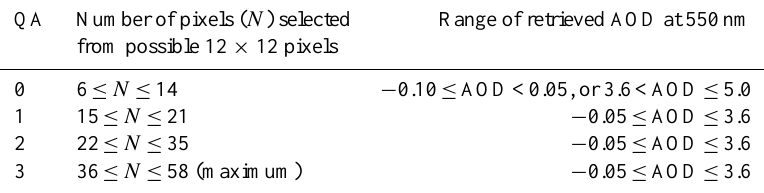
Table 2. Conditions for determining pixel QA values from 0 to